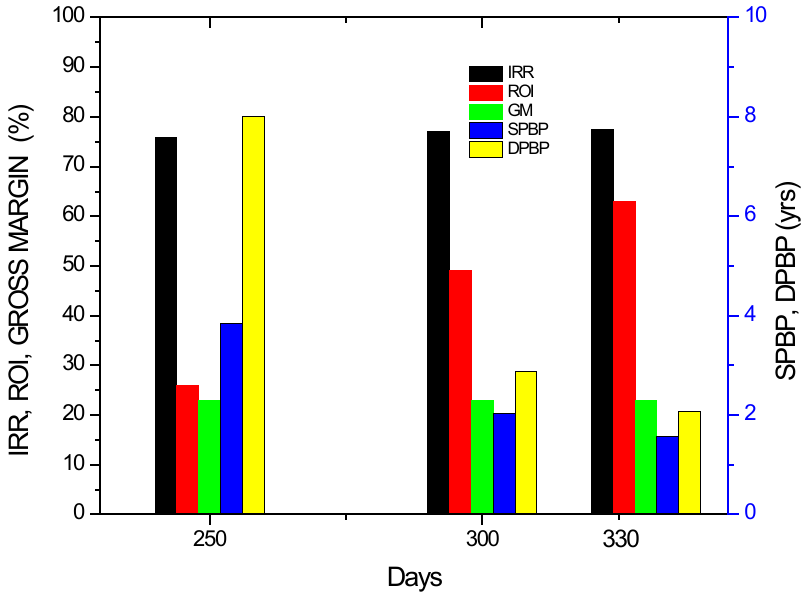
Fig 3. Profitability criteria of the cookies production plant at different operation